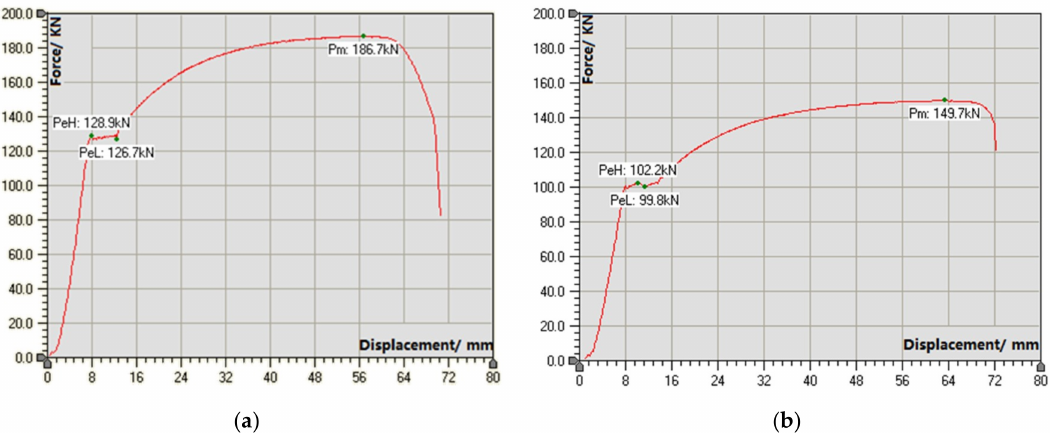
Figure 8. Force-displacement curves of the left-hand and right-hand threaded steel bolts with the diameter of Φ 20. ( a ) Left-hand threaded steel bolts; ( b ) right-hand threaded steel bolts.